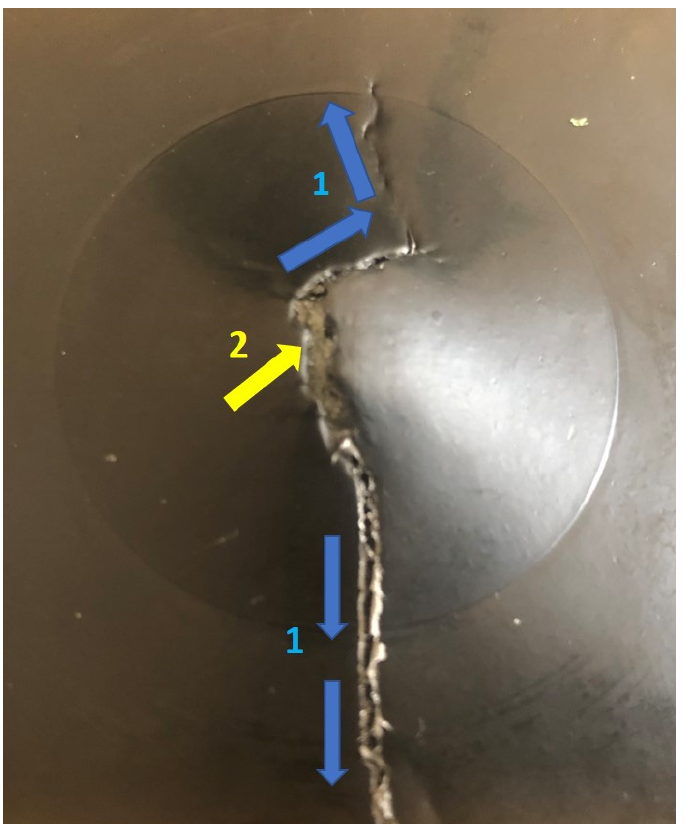
Figure 9. Lower skin damage progression of 30 J impacted reprocessed sandwich specimen during FAI test. 1 with blue mark—damage progression directions; 2 with yellow mark—cracked foam core.